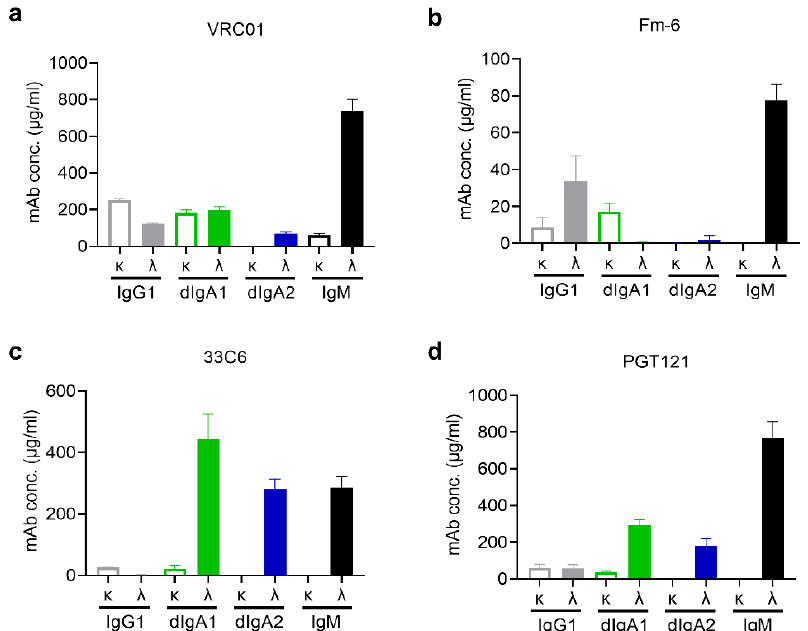
Figure 2. Antigen-specific mAb concentrations of isotypes IgG1, dIgA1, dIgA2, and IgM in culture supernatants of Expi293 cells were determined 5 days post-transfection using ELISA. Four different panels to test the preference for κ versus λ light chains with four different heavy chains were generated for ( a ) VRC01, an anti-HIV Env CD4 binding site mAb [7]; ( b ) Fm-6, an anti-SARS spike protein mAb [12]; ( c ) 33C6, an anti-HIV Env V3 loop mAb [13]; and ( d ) PGT121, a broadly neutralizing anti-HIV Env mAb targeting a complex glycan-dependent epitope [8]. Bars representing IgG1 (grey), dIgA1 (green), dIgA2 (blue), and IgM (black) are either open bars for the κ or solid bars for the λ light-chain versions. Error bars represent standard errors of the means. Data are representative of two independent experiments.